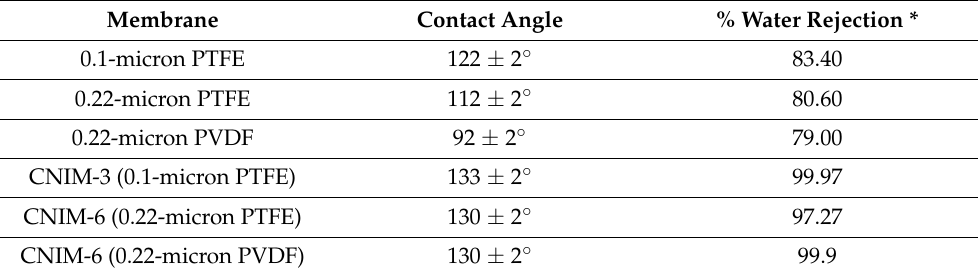
Table 1. Water contact angle for prepared membranes and the results of water rejection.